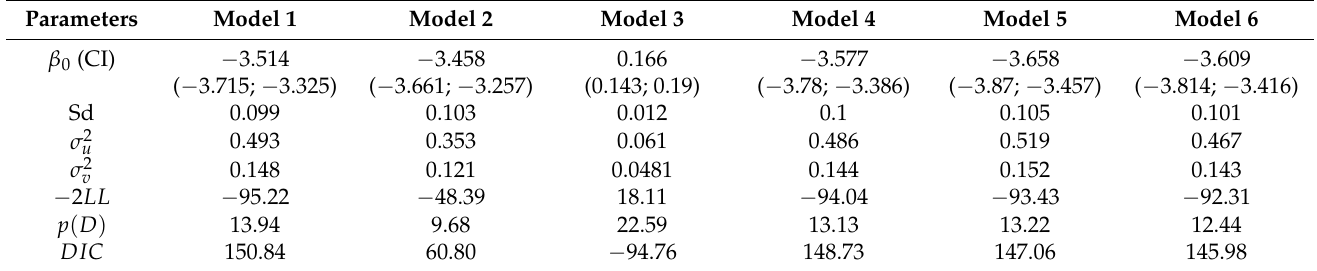
Table 2. A comparison of spatial models for mapping child wasting in Malawi using 2015-16 MDHS.